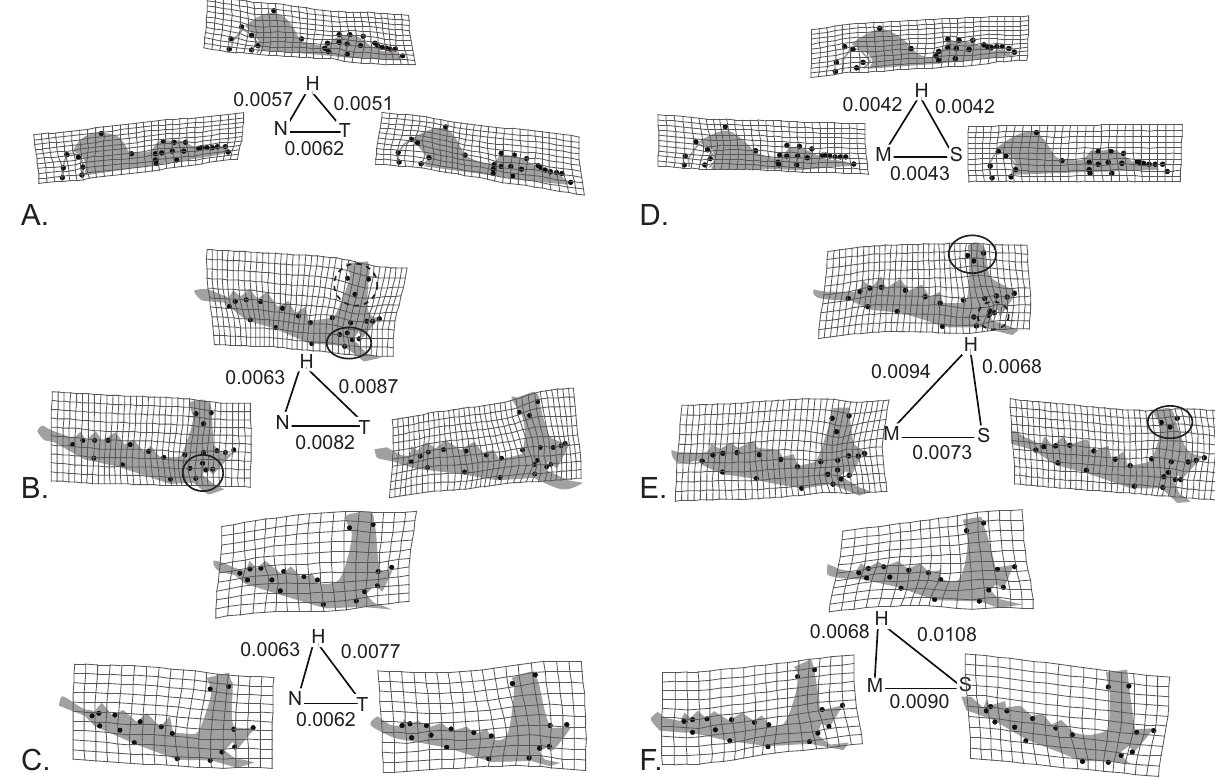
Figure 4. Comparison of pure race and hybrid phenotypes. ( A–C ) skulls, medial mandibles and lateral mandibles from the Novosibirsk-Tomsk hybrid zone. ( D–F ) the same three structures from the Moscow-Seliger hybrid zone. The mean shape of each hybrid and pure race groups is shown as a thin-plate spline deformation from the grand sample mean (exaggerated by 10x). Cartoon outlines of each structure have been added to make the landmark configurations more intelligible. Solid circles highlight examples where the hybrid phenotype is like one of the parents; dashed circles highlight unique features of the hybrids. Distances between the hybrid and pure race means are reported in Procrustes units along edges of a triangle proportional to those